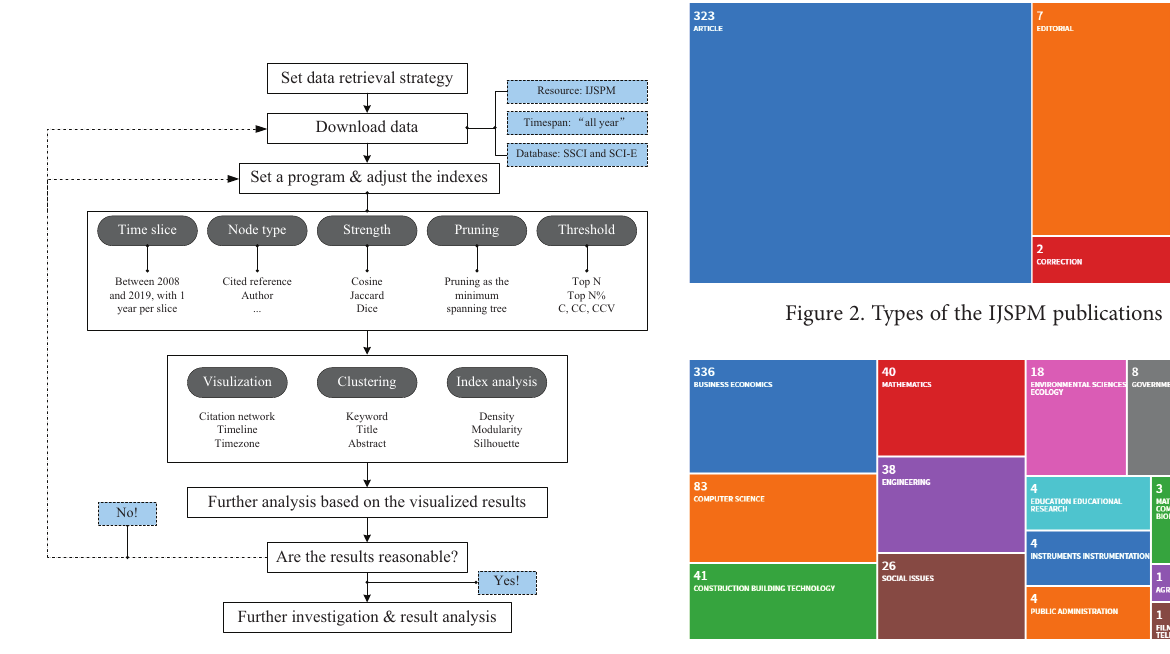
Figure 3. Research directions of all the papers in the IJSPM